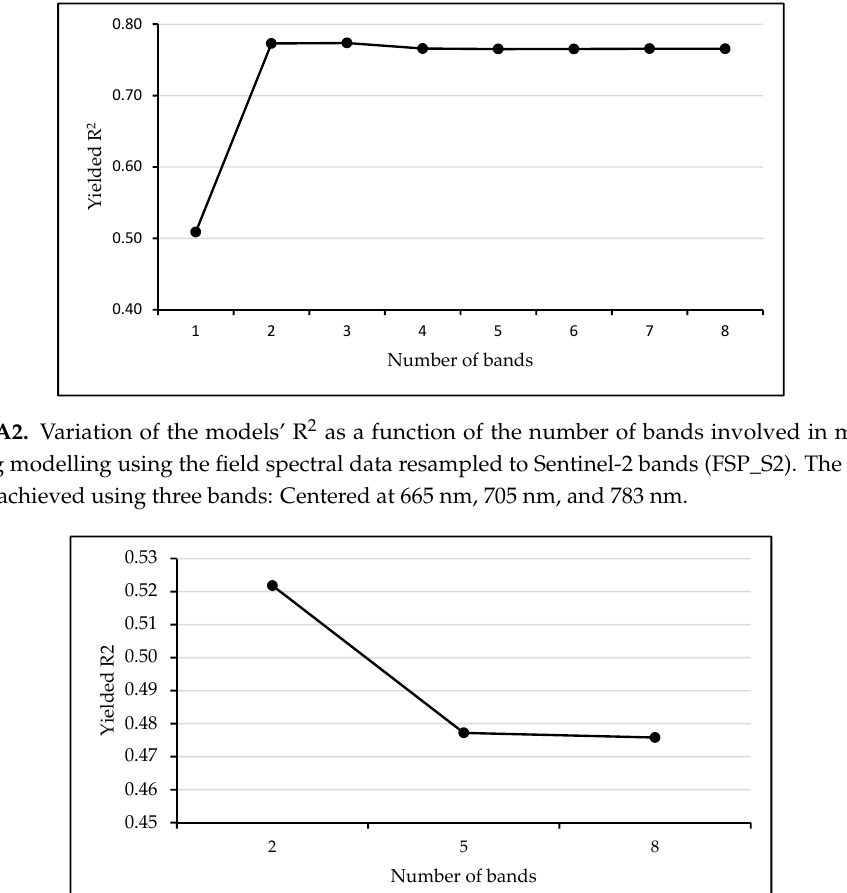
Figure A1. Variation of the models’ R 2 as a function of the number of bands involved in machine learning modelling using the field spectral data resampled to 10 nm (FSP_10). The highest R 2 was achieved using three bands centered at 565 nm, 675 nm, and 775 nm.